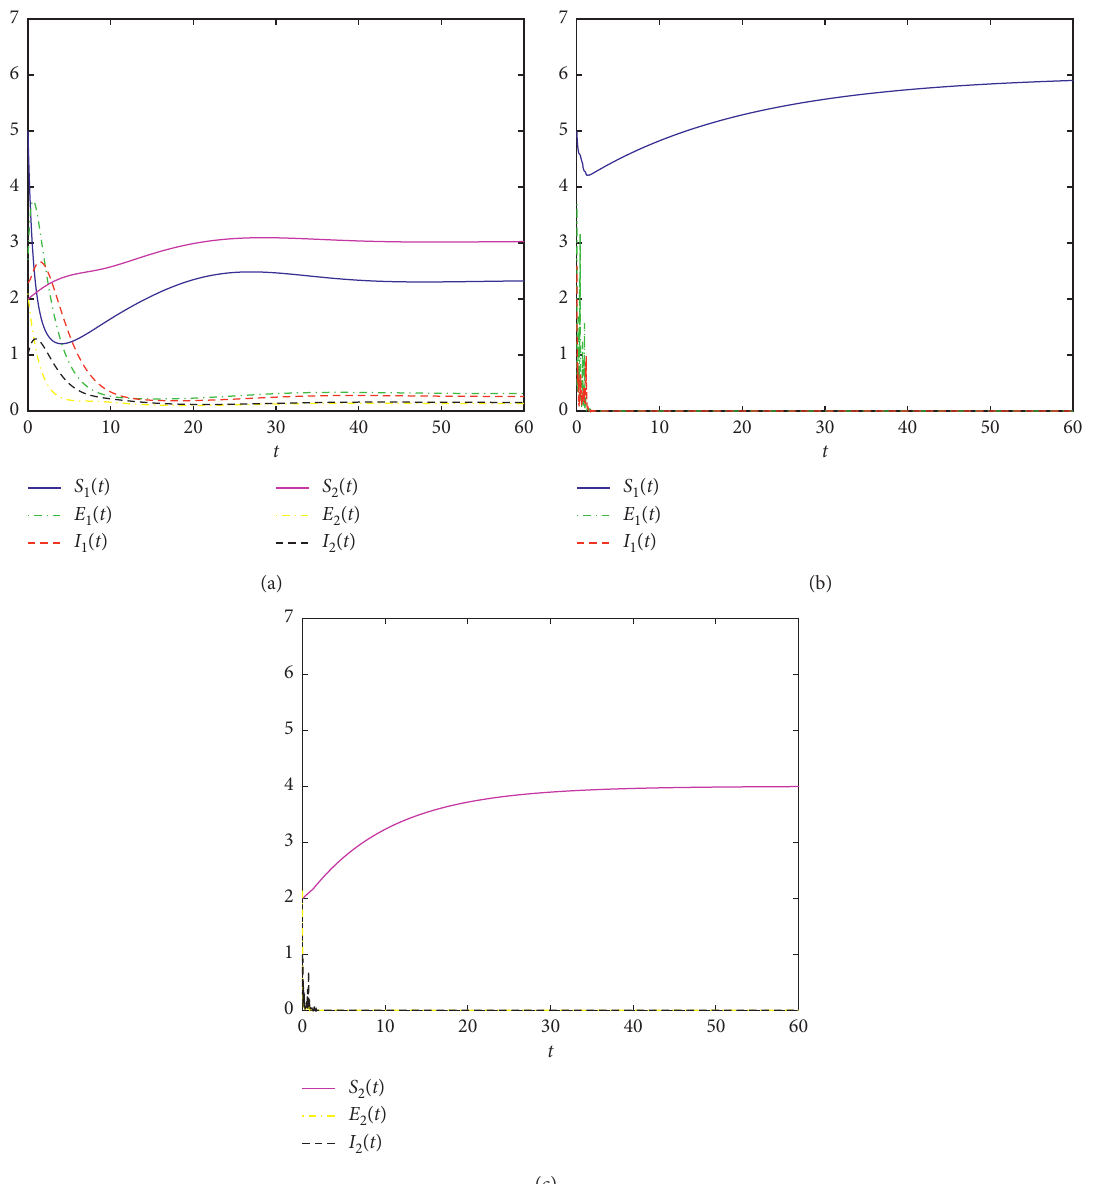
Figure 3: The trajectories with R > 1 and two different incidence functions: (a) the trajectory without stochastic perturbation; (b, c) the 0 trajectories with stochastic perturbations where parameters are shown in Example